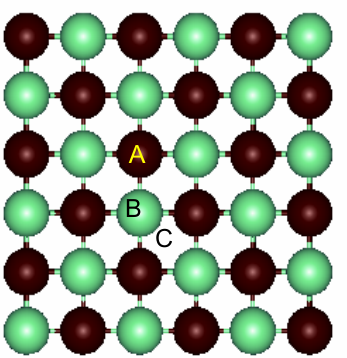
Figure 3. Top view of the relaxed surface. The labels for the three different sites for adsorption are A: on-top of Ti atoms; B: on-top of N atoms and C: fourfold